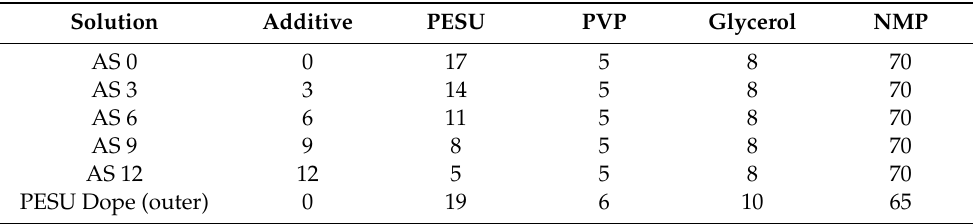
Table 1. Recipes of additive solutions as well as the outer dope solution. PESU denotes poly(ether sulfone). All values are given in